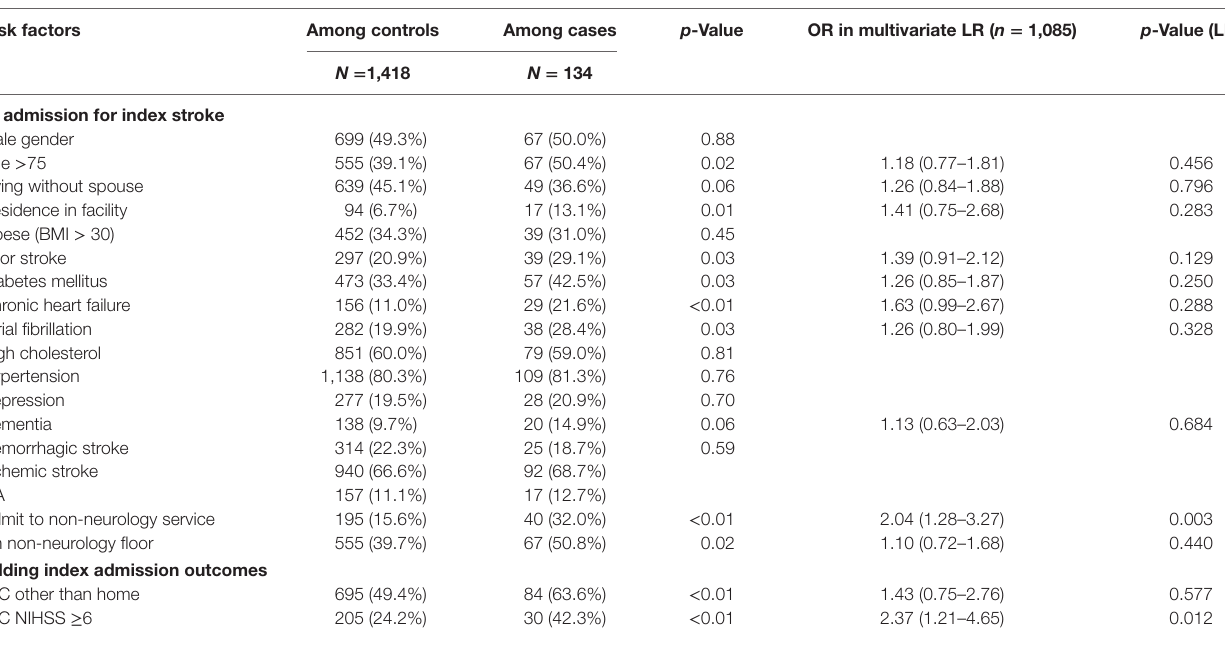
TaBle 1 | Risk factors for stroke 30-day